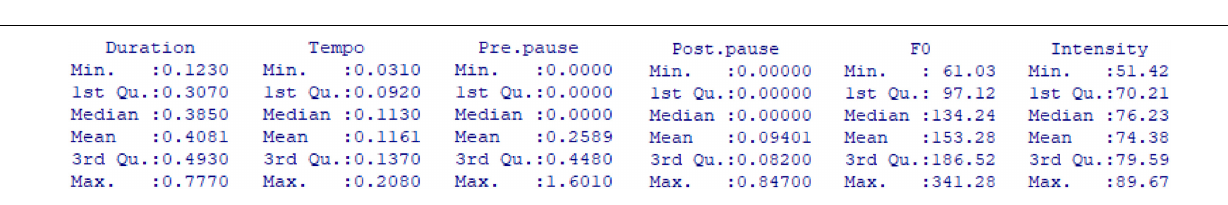
FIGURE 3 | Distribution of ni zhidao in four sentence positions.